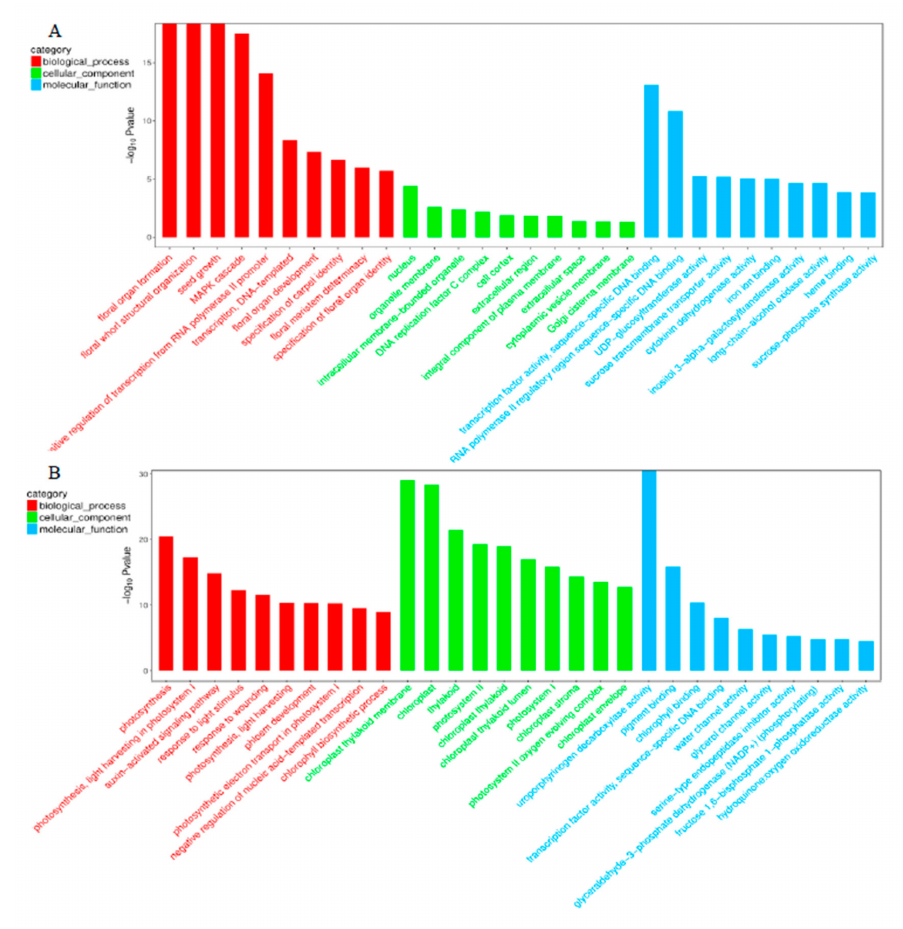
Figure 5. The gene ontology classification of up-regulated genes ( A ) and down-regulated genes ( B ) between young shoot apices containing male flower buds and female flower buds. To further test the reliability of RNA-seq, 17 genes were randomly selected from the 871 DEGs based on sequencing, and quantitative reverse transcription polymerase chain reaction (qRT-PCR) analysis was performed with specific primers using FS1 and FS10 samples. The results showed that the gene expression patterns of FS1 vs. FS10 examined by qRT-PCR analyses were similar to those revealed by RNA-seq (Figure 7A). Most of the expression patterns shown by qRT-PCR agreed with the RNA-seq ratios, with a relative coe ffi cient of R 2 = 0.9 (Figure